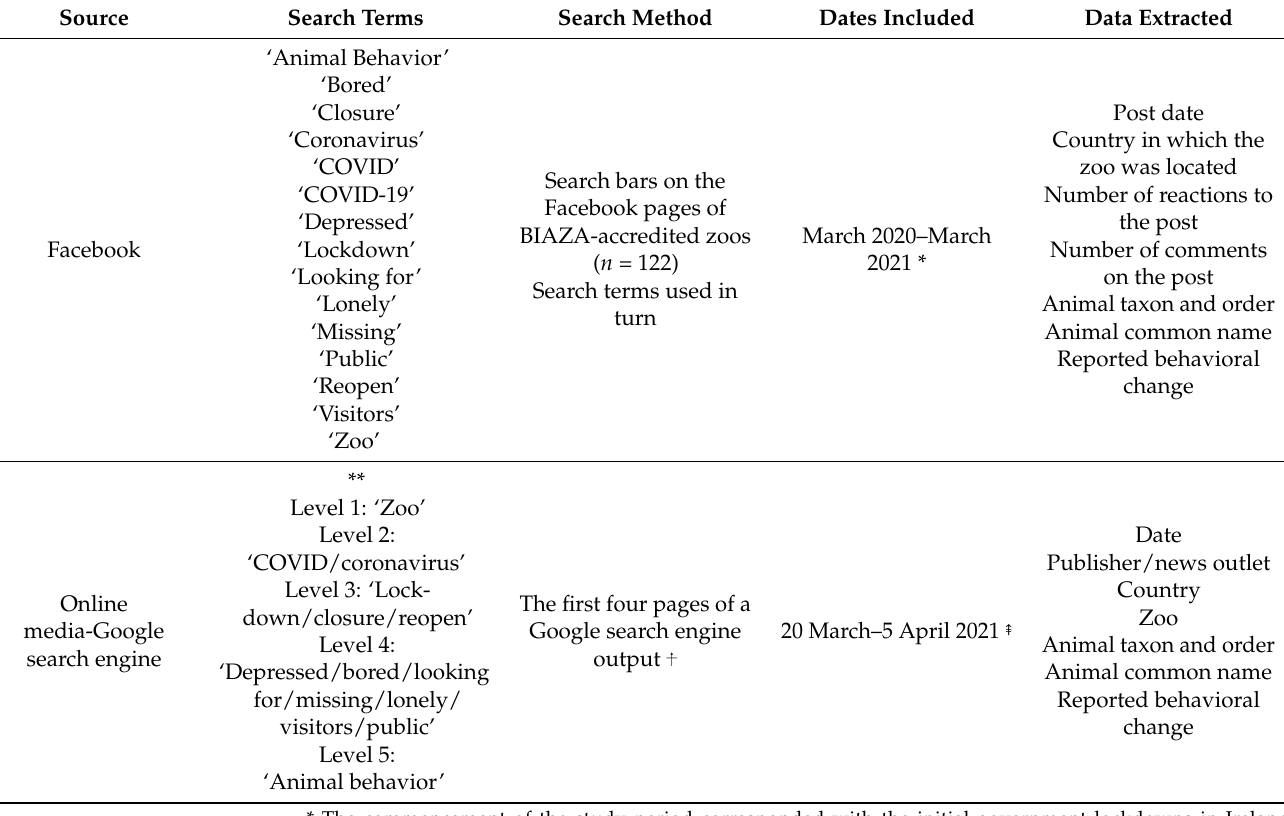
Table 1. An overview of the search terms applied to social and national/international media.